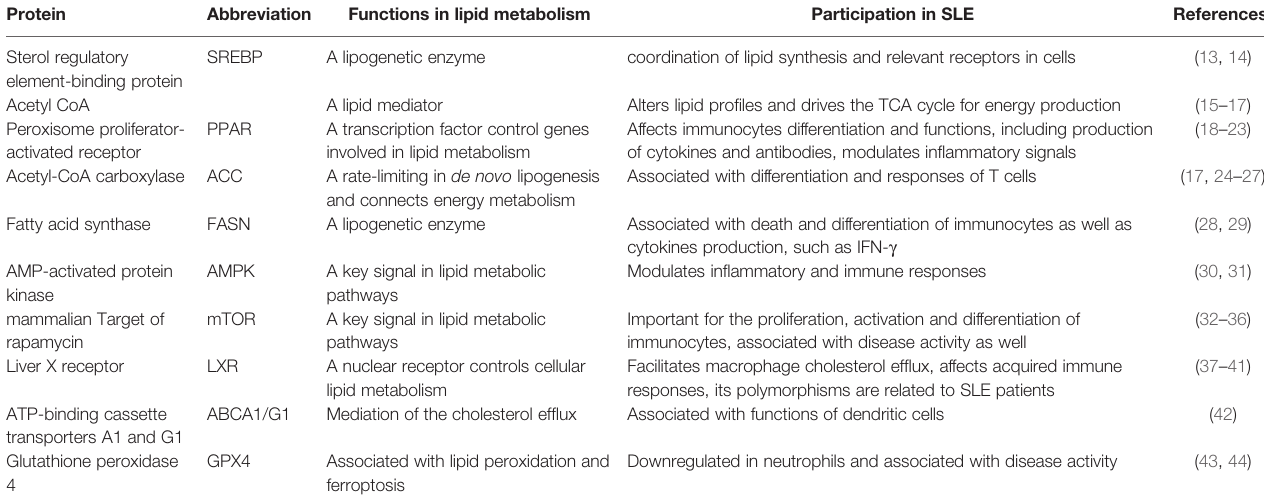
TABLE 1 | Key genes involved in lipid metabolism of